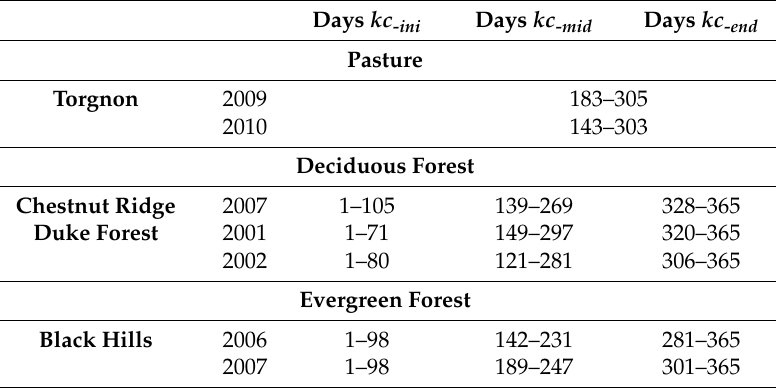
Table 2. Lengths of crop development stages (Julian day of beginning and end) respect to kc -ini , kc -mid and kc -end